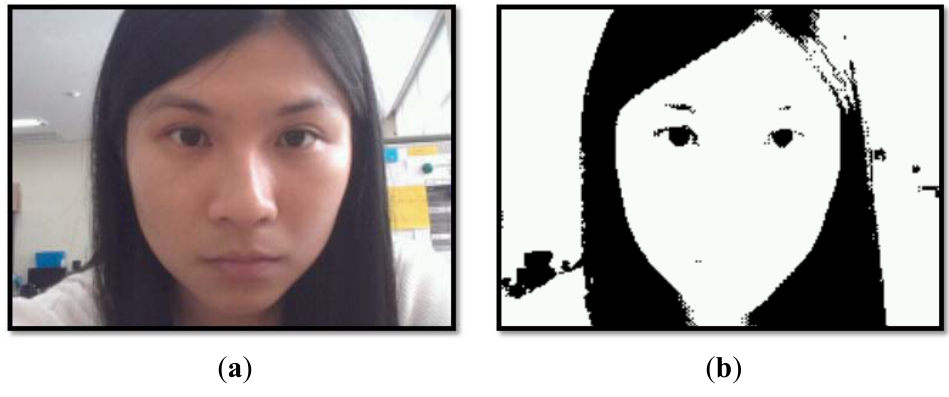
Figure 2. Eyes detection using the HRV color model approach. ( a ) Original face image captured by smartphone front video-sensor. ( b ) Converted binary threshold image. ( c ) The eyes location is indicated using the facial region; the eyes are located in the upper part and are vertically synchronized with each other, with an error tolerance of ±10